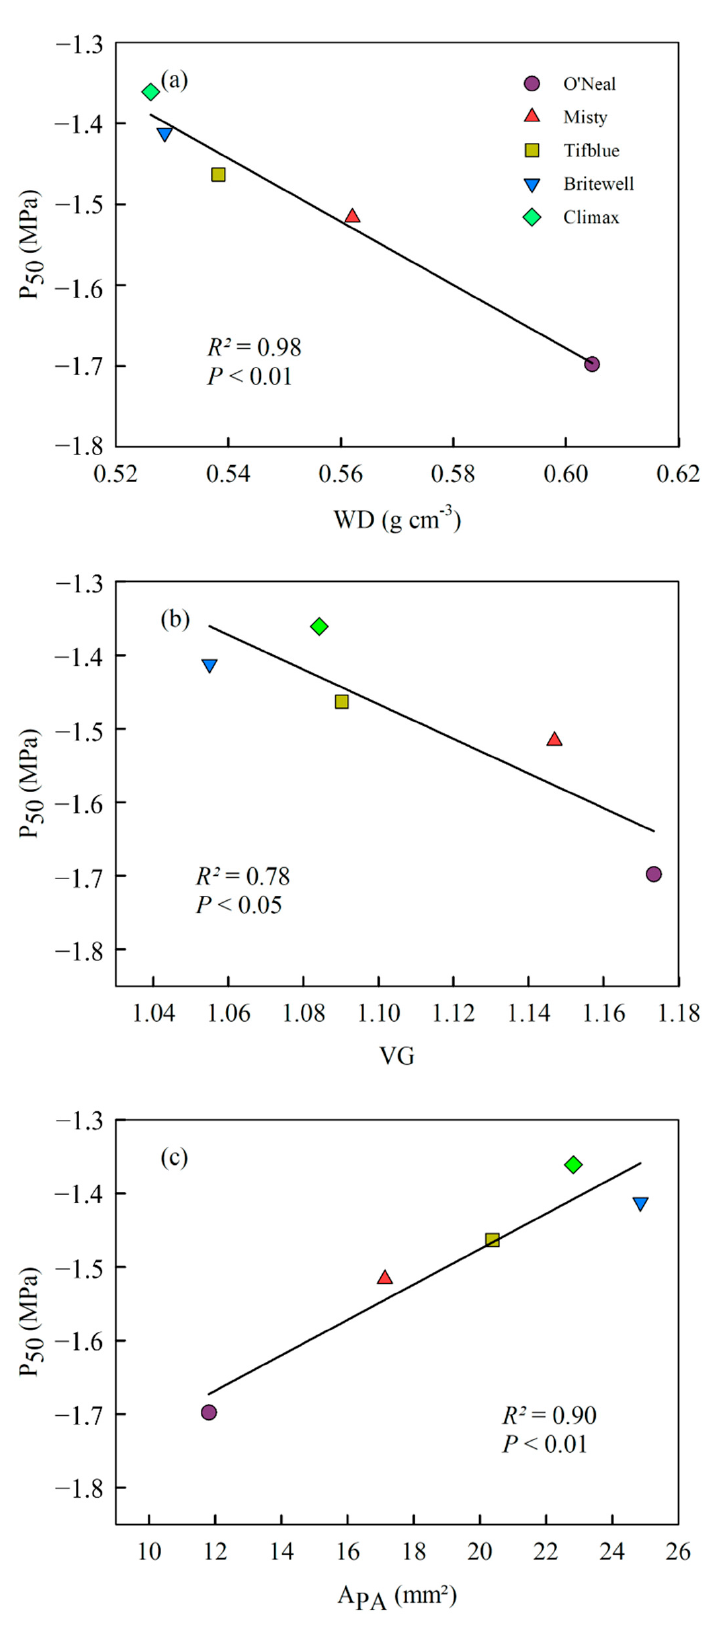
Figure 4. Linear analysis of P 50 and wood density (WD, ( a )), vessel-grouping index (VG, ( b )), and total pit aperture area per vessel wall area (A PA , ( c )) for five blueberry cultivars. Different symbols with different colors represent five cultivars.